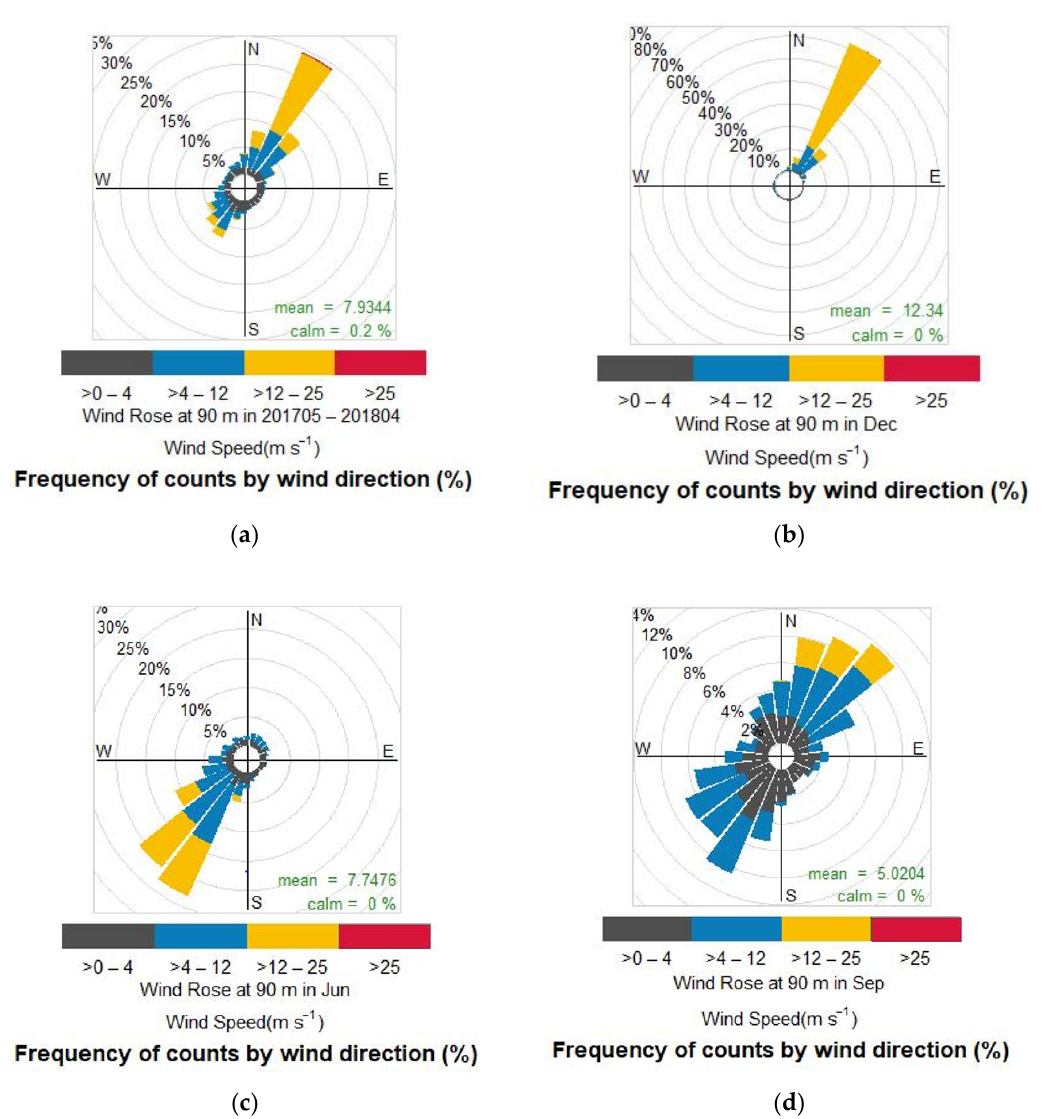
Figure 3. ( a ) Yearly wind rose; ( b ) wind rose of December 2017; ( c ) wind rose of June 2017; ( d ) wind rose of September 2017.